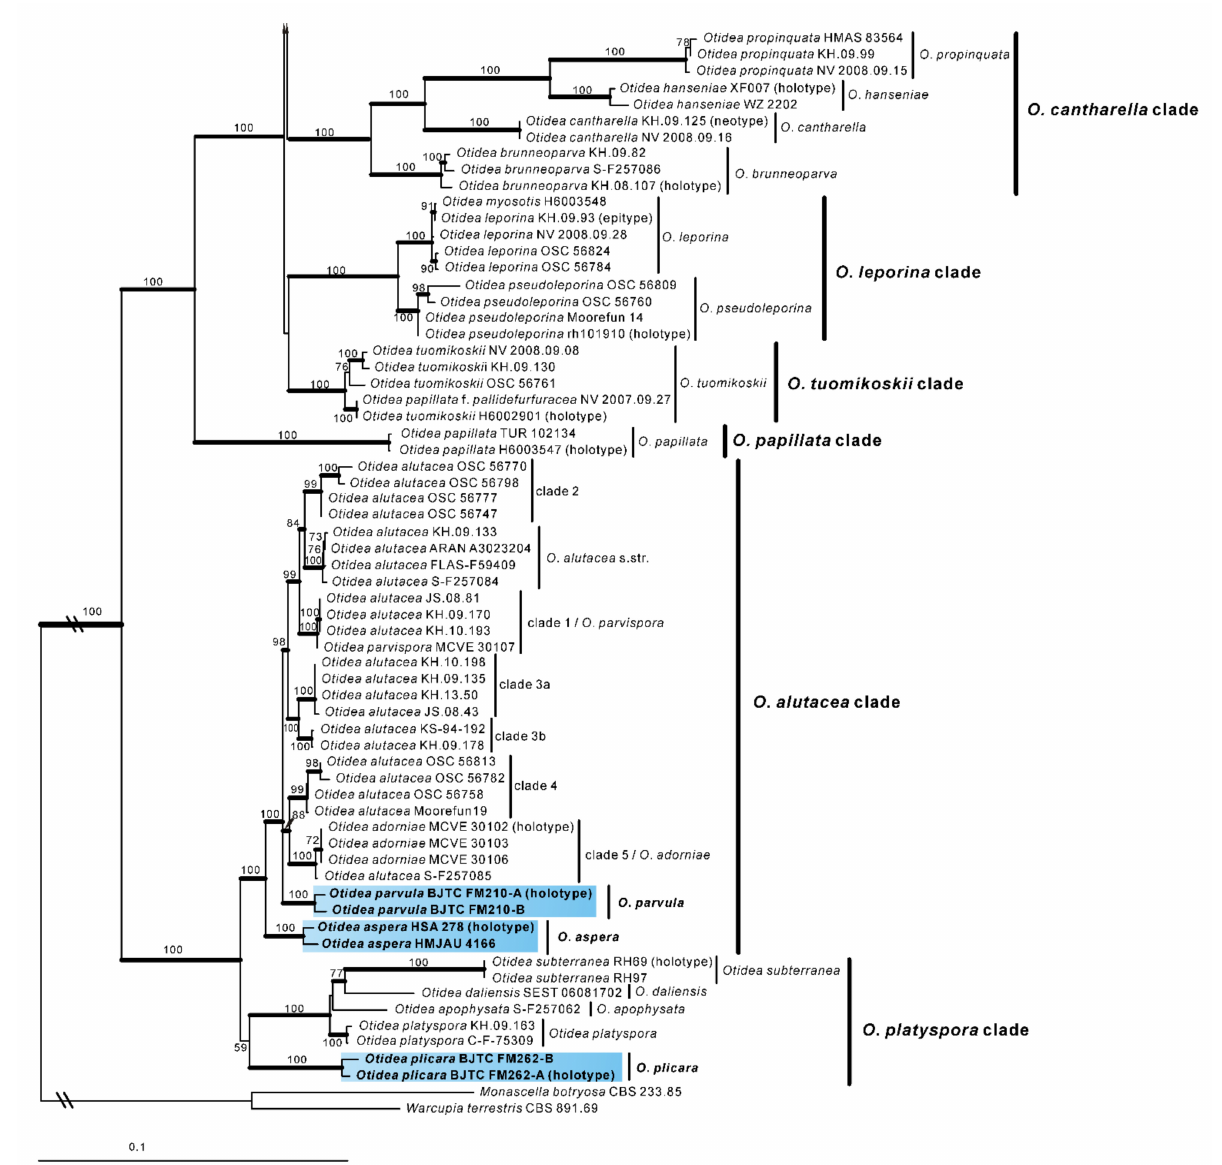
Figure 2. Phylogenetic tree generated from a maximum likelihood analysis based on ITS, nrLSU, tef1- α and rpb2 sequences, showing the phylogenetic relationships of Otidea . Monascella botryosa and Warcupia terrestris are the outgroups. Maximum likelihood bootstrap support values ( ≥ 50%) are indicated above the nodes as BS. Thick black branches received Bayesian posterior probabilities (BPP) ≥ 0.95. The new species are in bold font and highlighted by blue